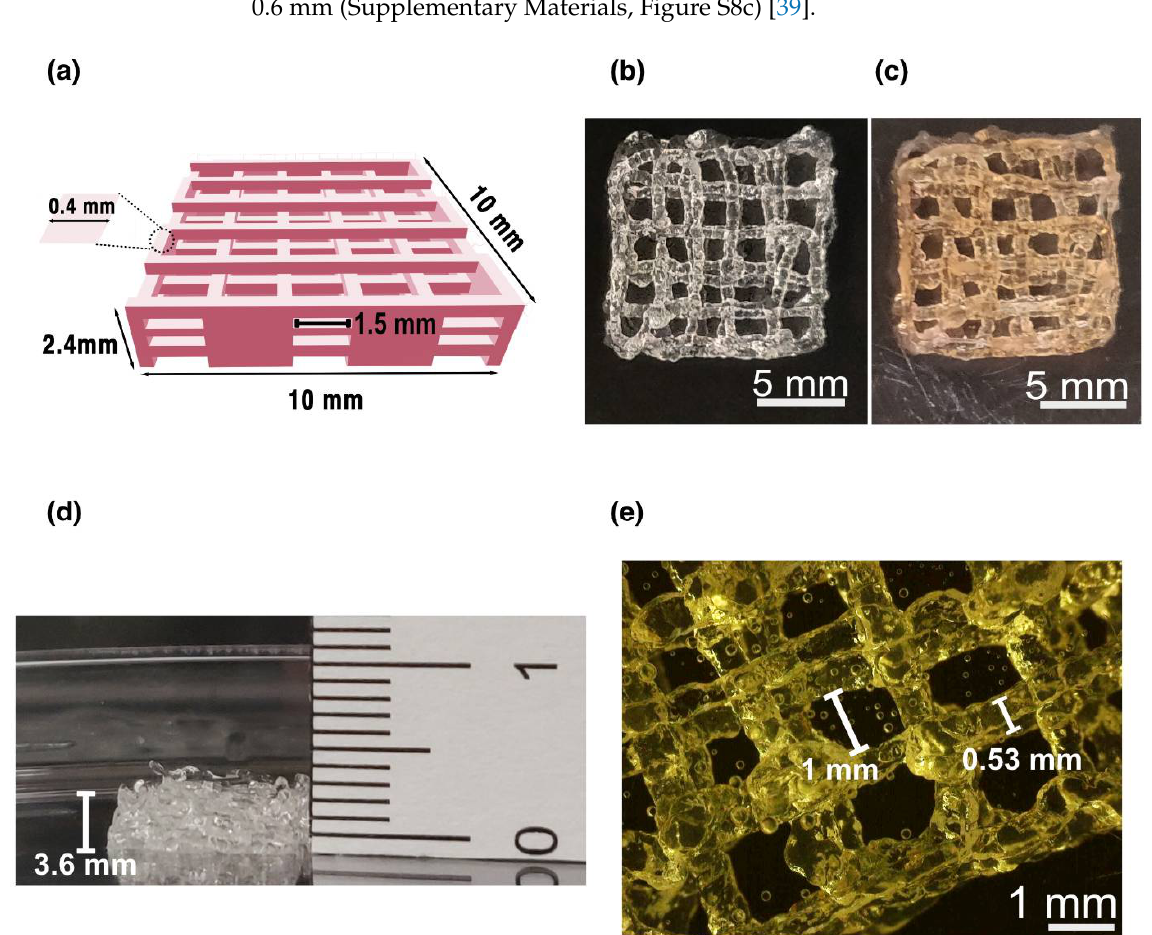
Figure 4. 3D printed bioink constructs. ( a ) A CAD representation of the structure before bioprinting with the dimensions showing line width and line spacing. Representative images of the top view of ( b ) dLM-G-PEG and ( c ) dLM-G-PEG-T 3D bioprinted structures (scale bar, 5 mm) followed by ( d ) the side view of the construct showing height. ( e ) The microscopic image of the dLM-G-PEG bottom layer represents the line width and line spacing (scale bar, 1